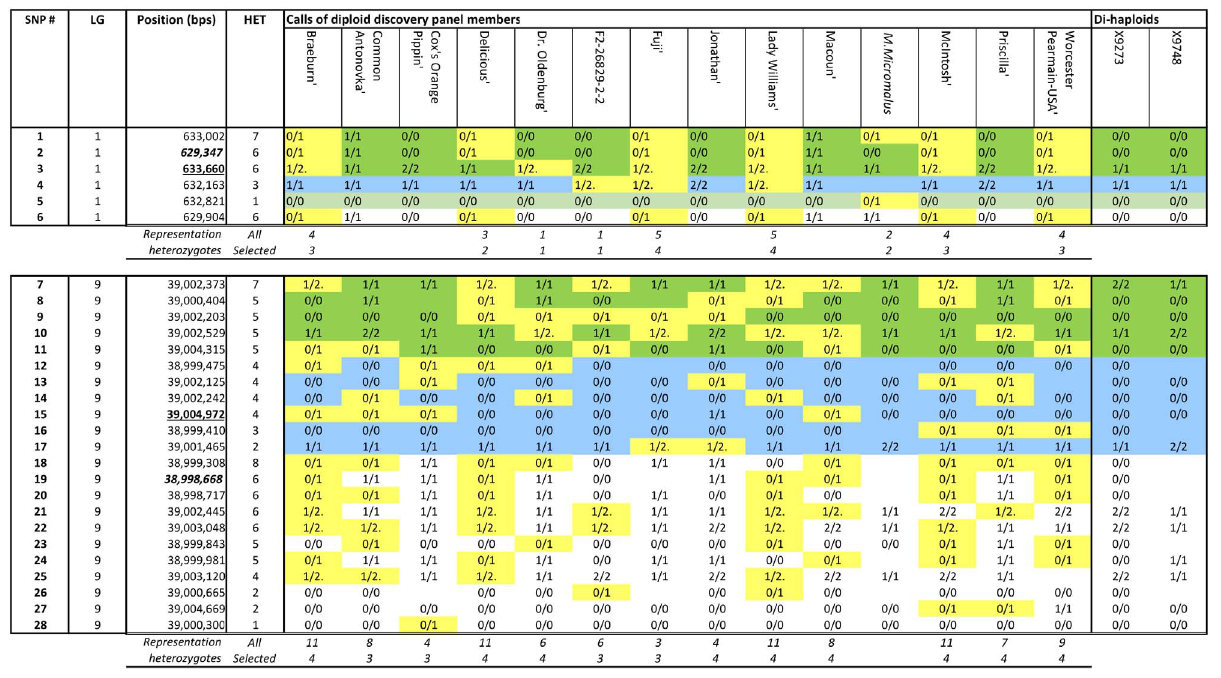
Figure 2. SNP selection within a single focal point (FP) of chromosomes (Chrs) 1 and 9. Genotype calls are presented for the discovery panel members: 0/1 and 1/2 indicates heterozygosity, all other codes indicate absence of polymorphism within an individual. Green, blue and orange filled cells relate to selected SNPs, having 5–8, 2–4, or just 1 heterozygous panel member/s, respectively. The physical positions at the extremities of the FP are in bold and italics (most proximal) or underlined (most distal). Within each FP, SNPs are sorted firstly by being selected or not, and secondly according to the number of heterozygous members (HET). In the Chr1-FP example, SNP-6 was not selected, as its heterozygosity pattern is identical to that of SNP-2. The single-member-heterozygote SNP-5 was included because no other more polymorphic SNP markers were available to reach the target of 11 SNPs and no nearby FPs had a specific SNP for the same panel member. In the Chr9-FP example all highly specific SNPs were ignored, as there were sufficient markers of higher heterozygosity available. The selected SNPs show a homogeneous representation of the diploid panel members.